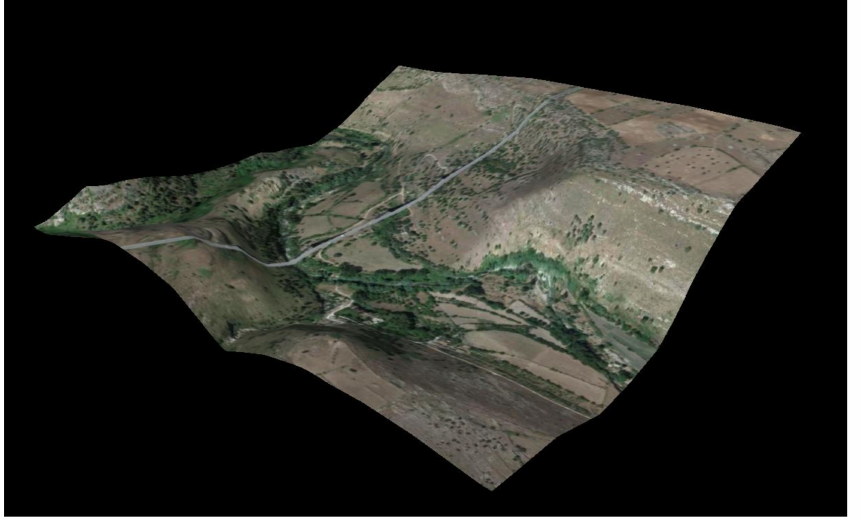
Figure 26. Terrain mesh applying the terrain